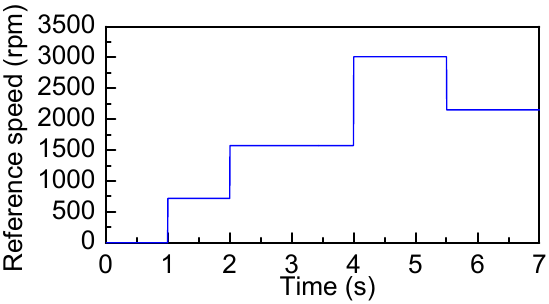
Figure 24. The reference speed variation with the DC-link voltage control strategy when torque is limited at 190 Nm.